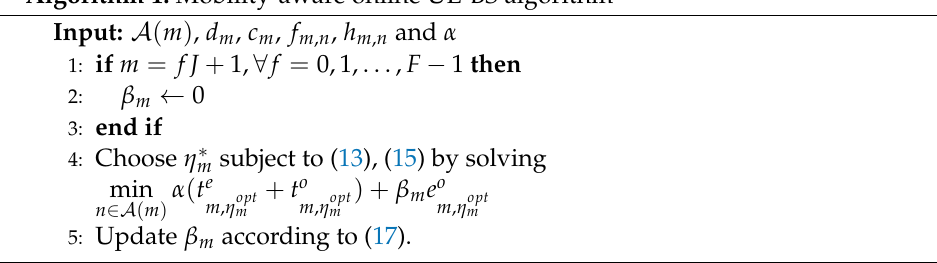
Algorithm 1: Mobility-aware online UE-BS